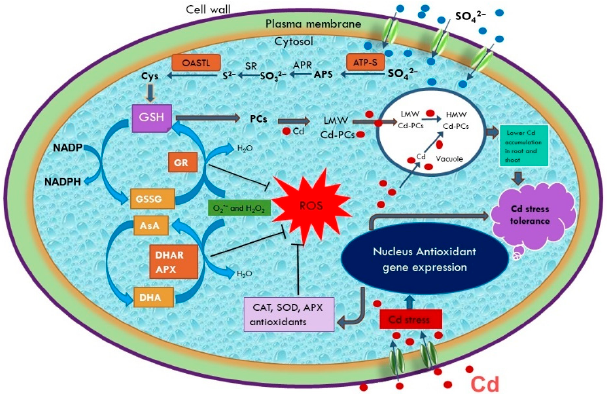
Figure 8. Simplified representation of the major mechanisms and signal transduction pathways underlying sulfur-mediated alleviation of cadmium stress in plants. HMW, high molecular weight; LMW, low molecular weight. The other acronyms in the figure are explained in the text.